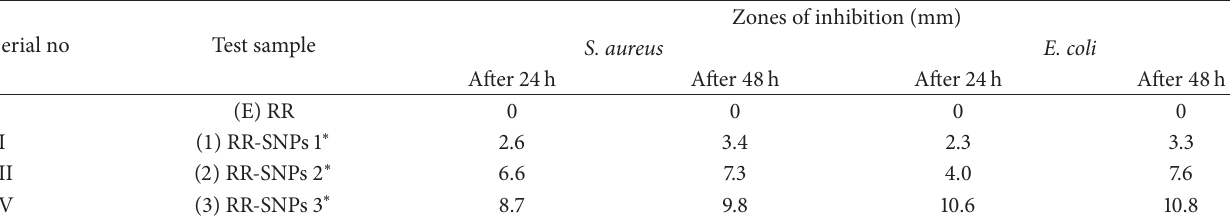
Table 2: Antibacterial activity results of RR and